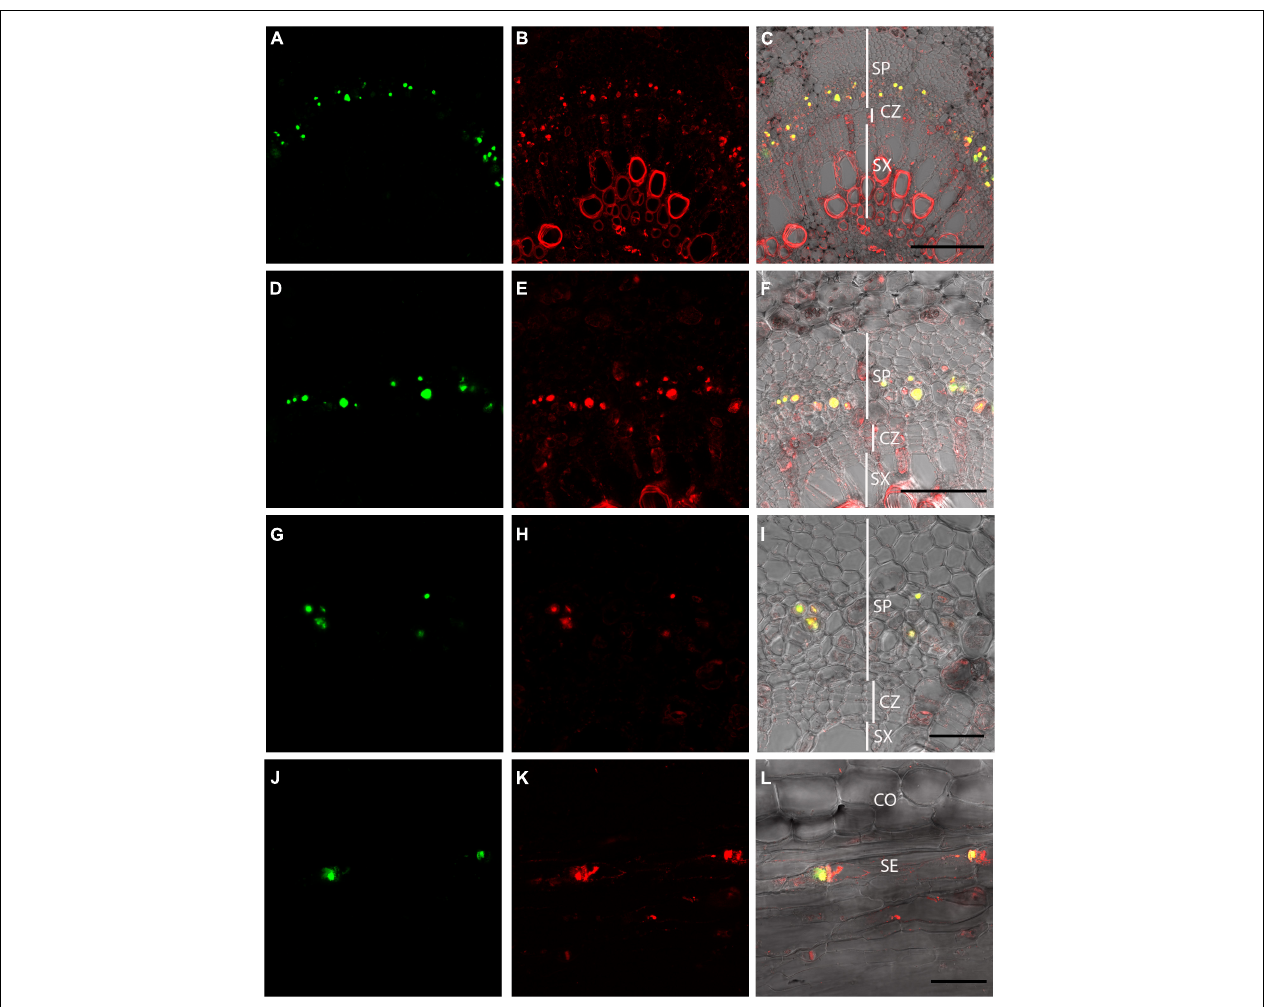
FIGURE 4 | Dual labeling of P-proteins with OGA 488 and SR101 in P. tremula × P. alba (717) stem sections. (A–C) Poplar stem transverse section labeled with OGA 488 (green signal in A ) and SR101 (red signal in B ). Overlay (C) shows OGA 488 signal colocalizes with SR101 within the secondary phloem (yellow) but SR101 stains additional cells and structures. Similar results are shown for increasing magnification in (D–I) . (J–L) Poplar longitudinal stem labeled with OGA 488 (green signal in J ) and SR101 (red signal in K ) showing colocalization within sieve elements P-proteins near sieve plates. SR101 also stains additional structures in other cell types (K,L) . CO, cortex; SE, sieve element; CZ, cambial zone; SP, secondary phloem; SX, secondary xylem. Scale bars: (A–C) 100 µ m, (D–F) 50 µ m, (G–L) 20 µ